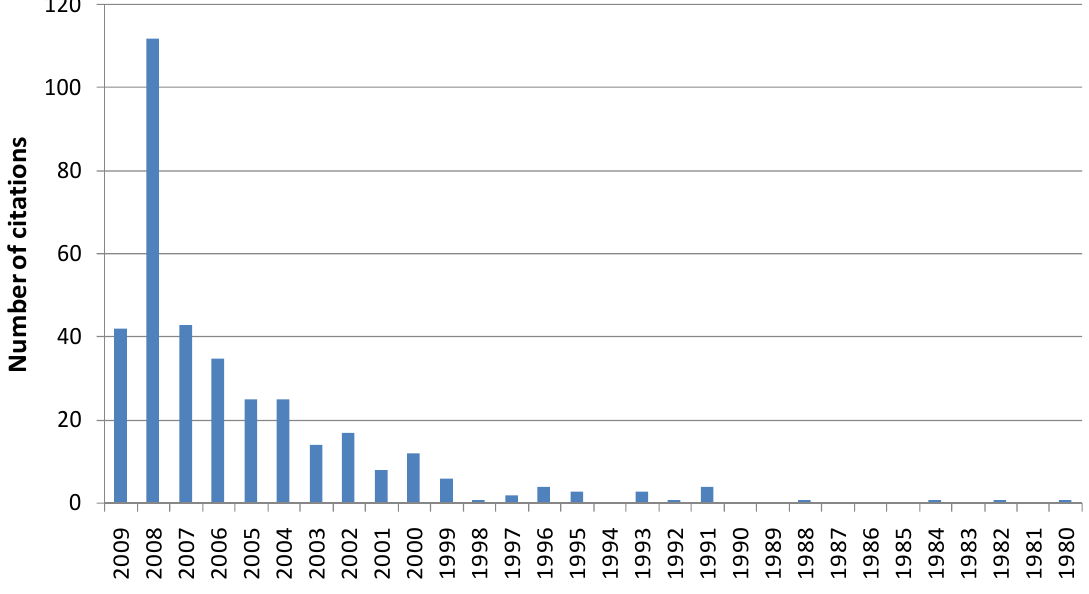
Figure 1. Frequency distribution of citations in this report across publication